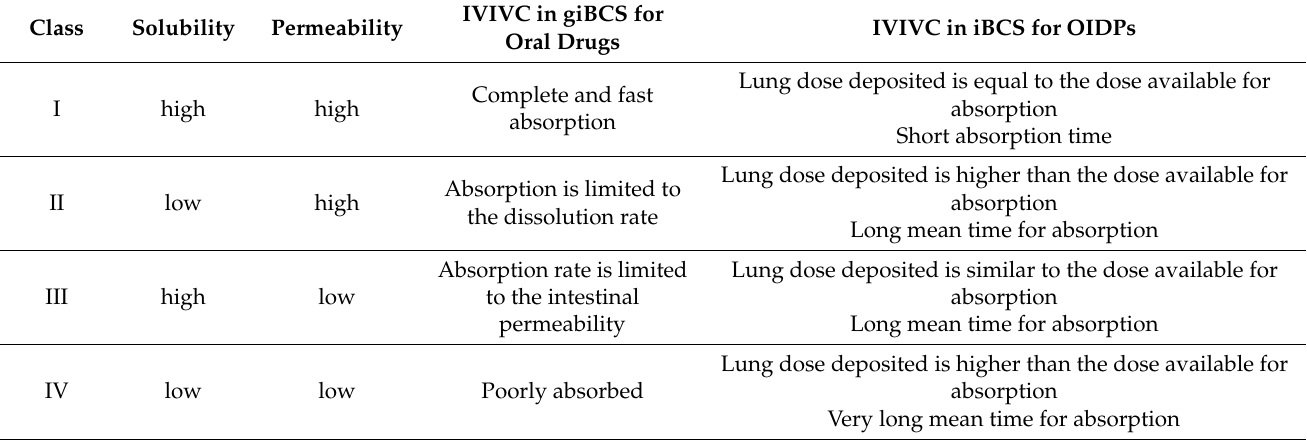
Table 3. Comparison of the Biopharmaceutical Classification System for oral drugs (giBCS) with immediate-release formulations vs. the proposed categories in the Biopharmaceutical Classification System for inhaled compounds (iBCS). Adapted from Amidon et al. [118] and Hastedt et al.